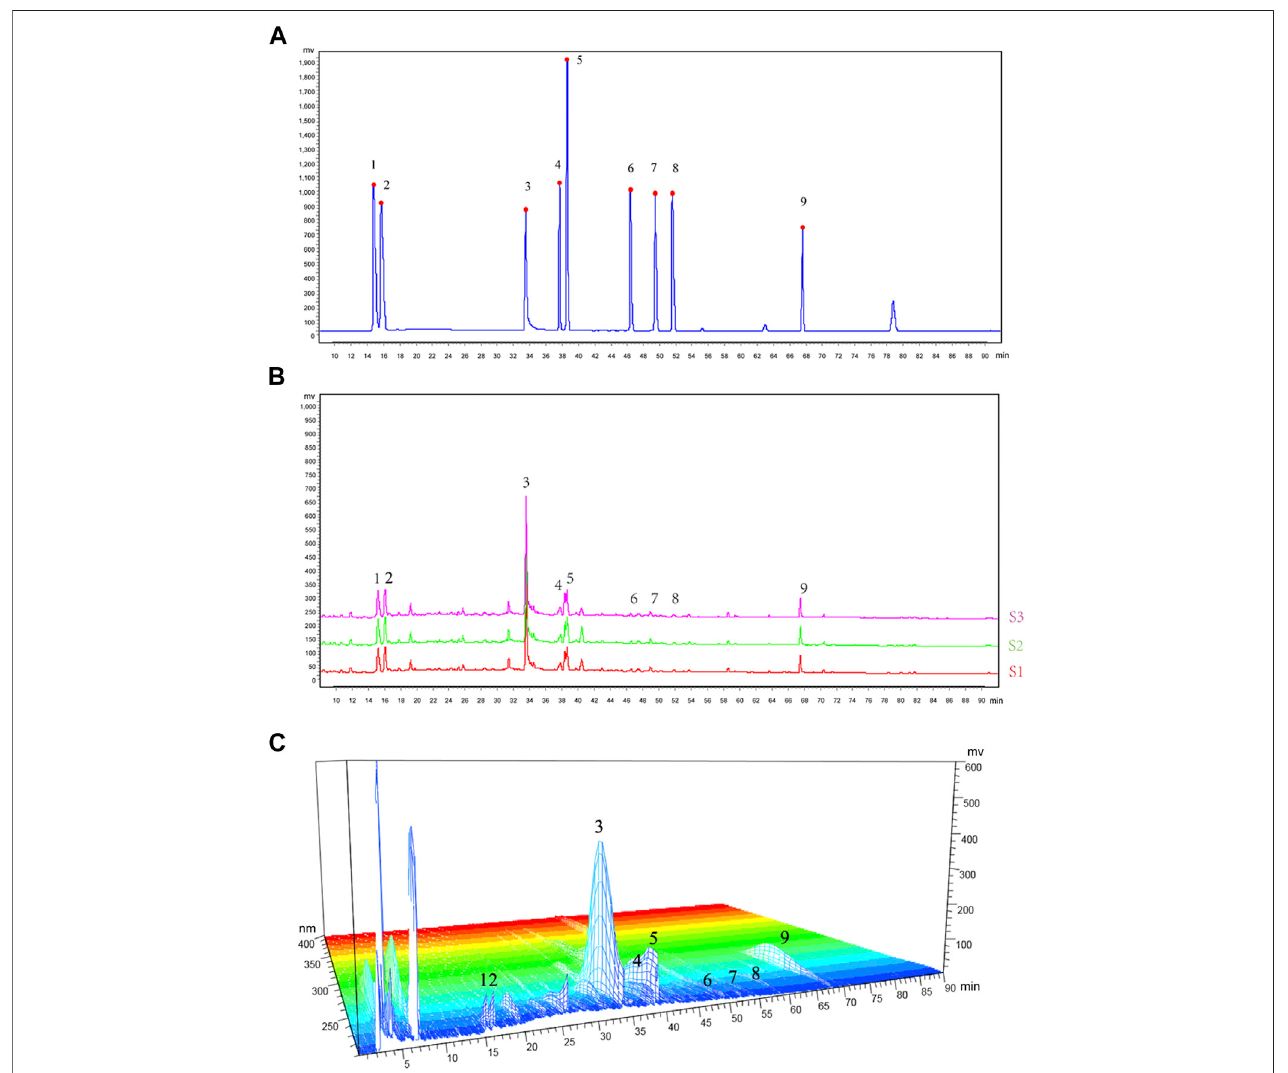
FIGURE 1 | HPLC fi ngerprinting of WTD. (A) HPLC fi ngerprinting chromatograms ofthe reference standards. (B) HPLC fi ngerprinting chromatograms of the WTD extracts. In the chromatograms the peaks are labeled as follows: 1) ephedrine hydrochloride; 2) pseudoephedrine hydrochloride; 3) paeoni fl orin; 4) verbasil-7-O- glucoside;5)glycyrrhizin;6)benzoylaconitine;7)benzoylneoaconitine;8)benzoylhypoaconitine;and9)glycyrrhizinate. (C) HPLC3D fi ngerprintingchromatogramsofthe WTD